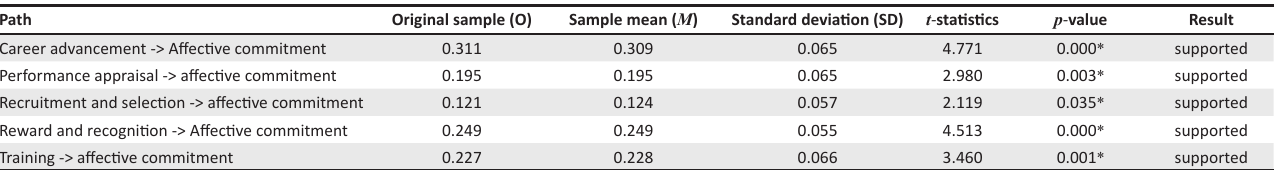
TABLE 6: Path coefficients matrix.